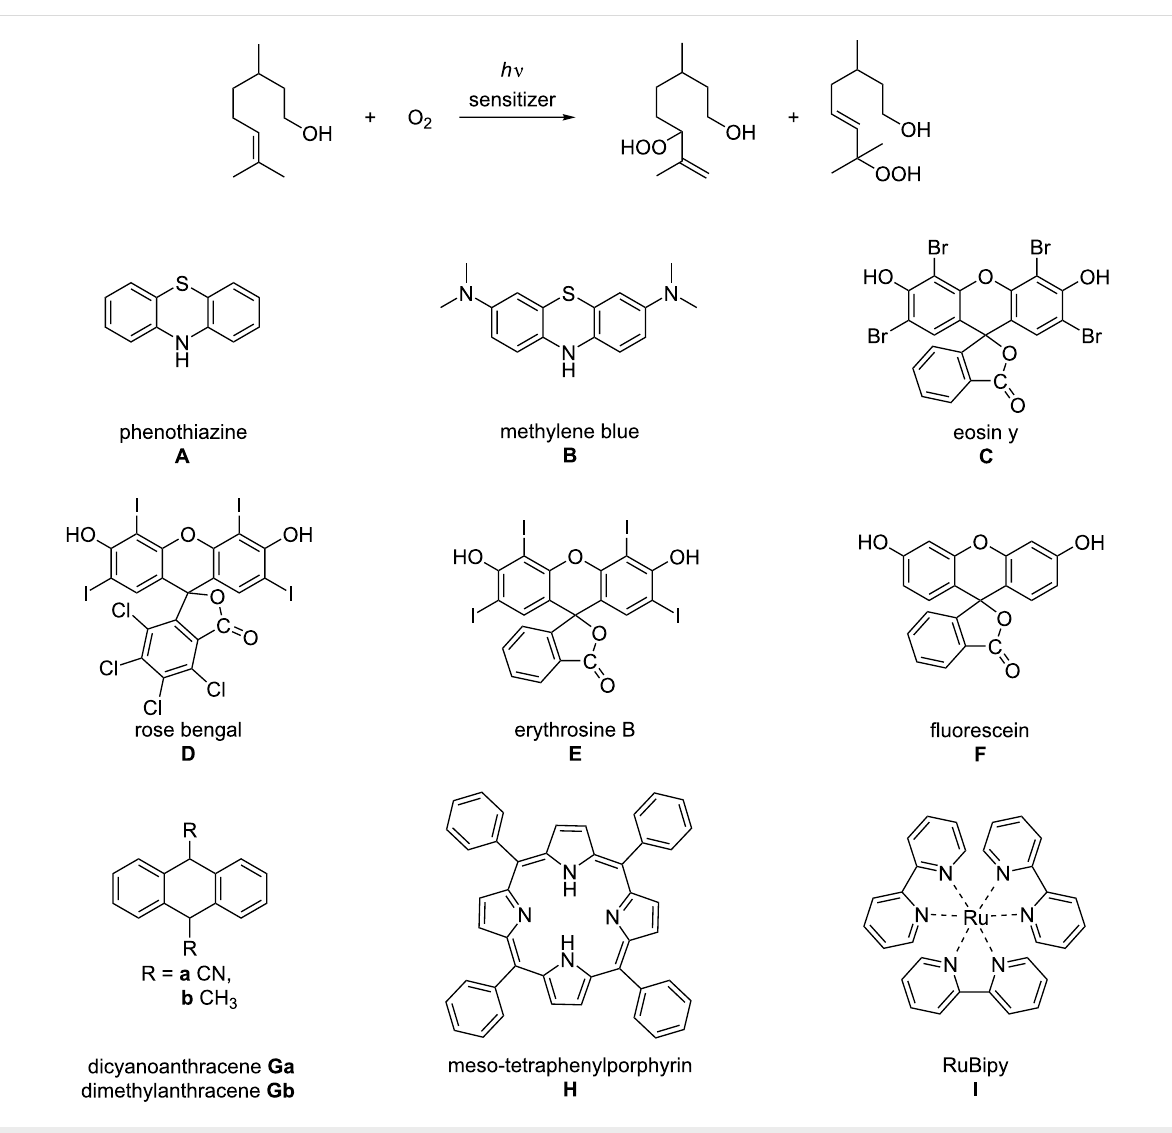
overlap with the Q bands of H at 593 and 649 nm to provide